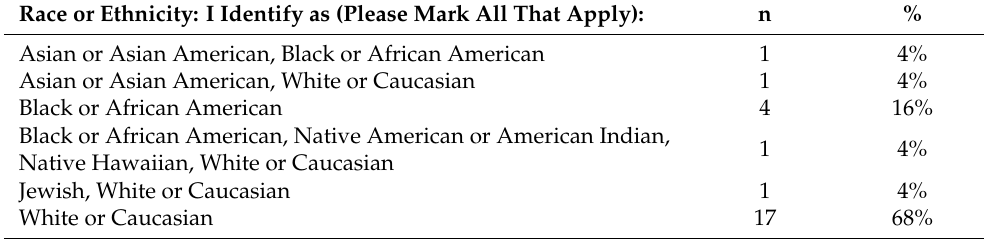
Table 1. Racial/ethnic identity of